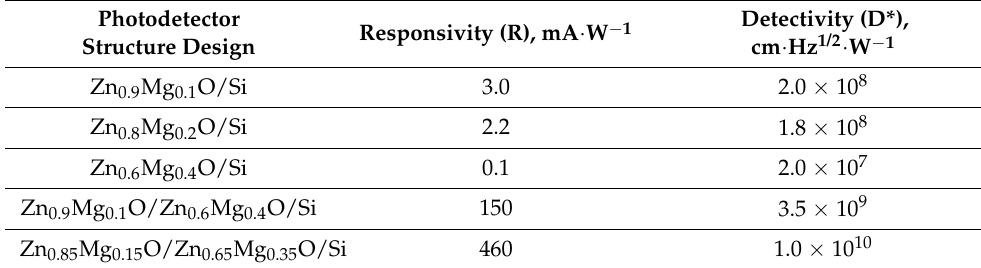
Table 3. Parameters of photodetectors on the basis of Zn 1 − x Mg x O films. Photodetector